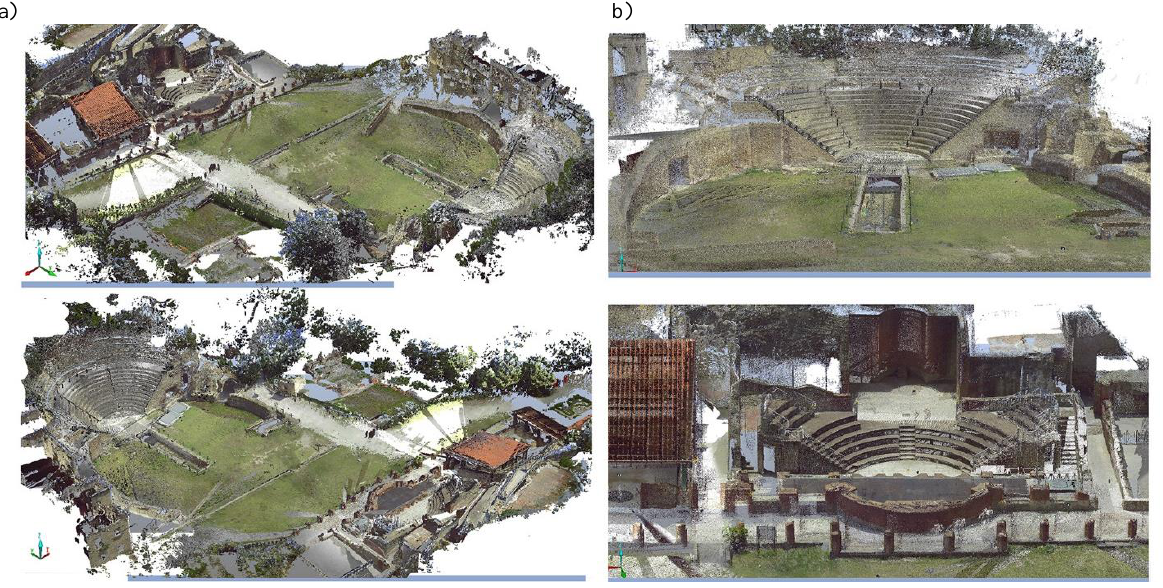
Figure 2: TLS point cloud. a) the entire theatres area (left); b) the Theatre and the Odeon (right).